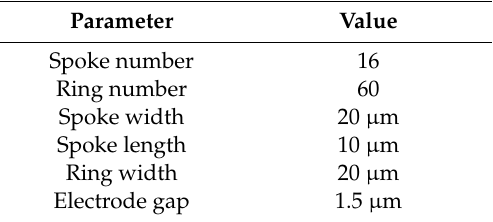
Table 2. The parameters of the selected MEMS disk